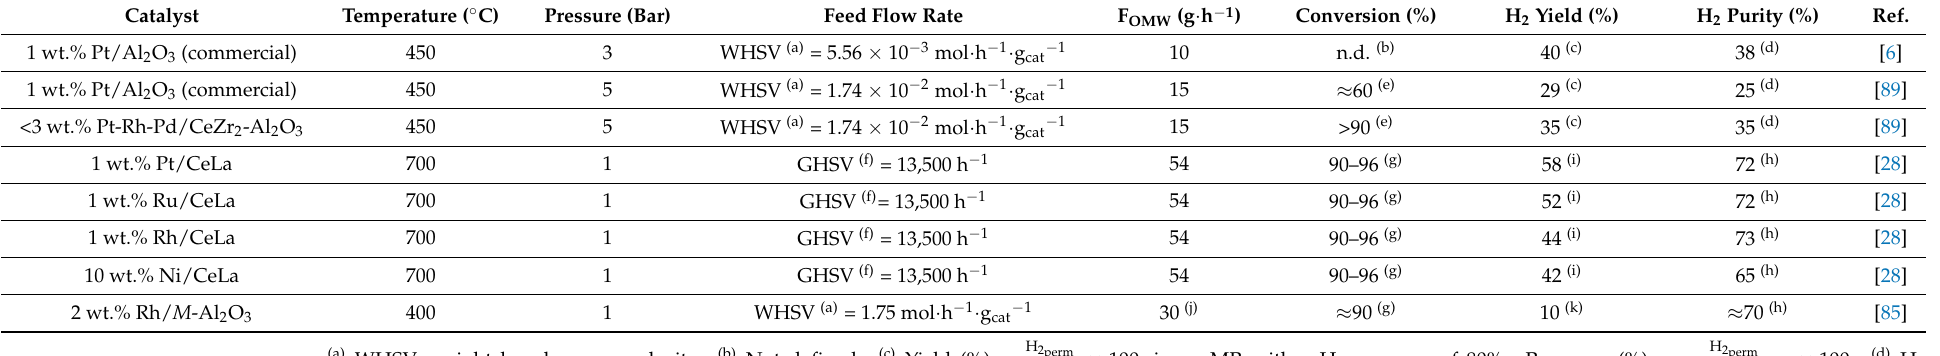
Table 3. Summary of the catalytic performance and operating conditions of several catalysts on